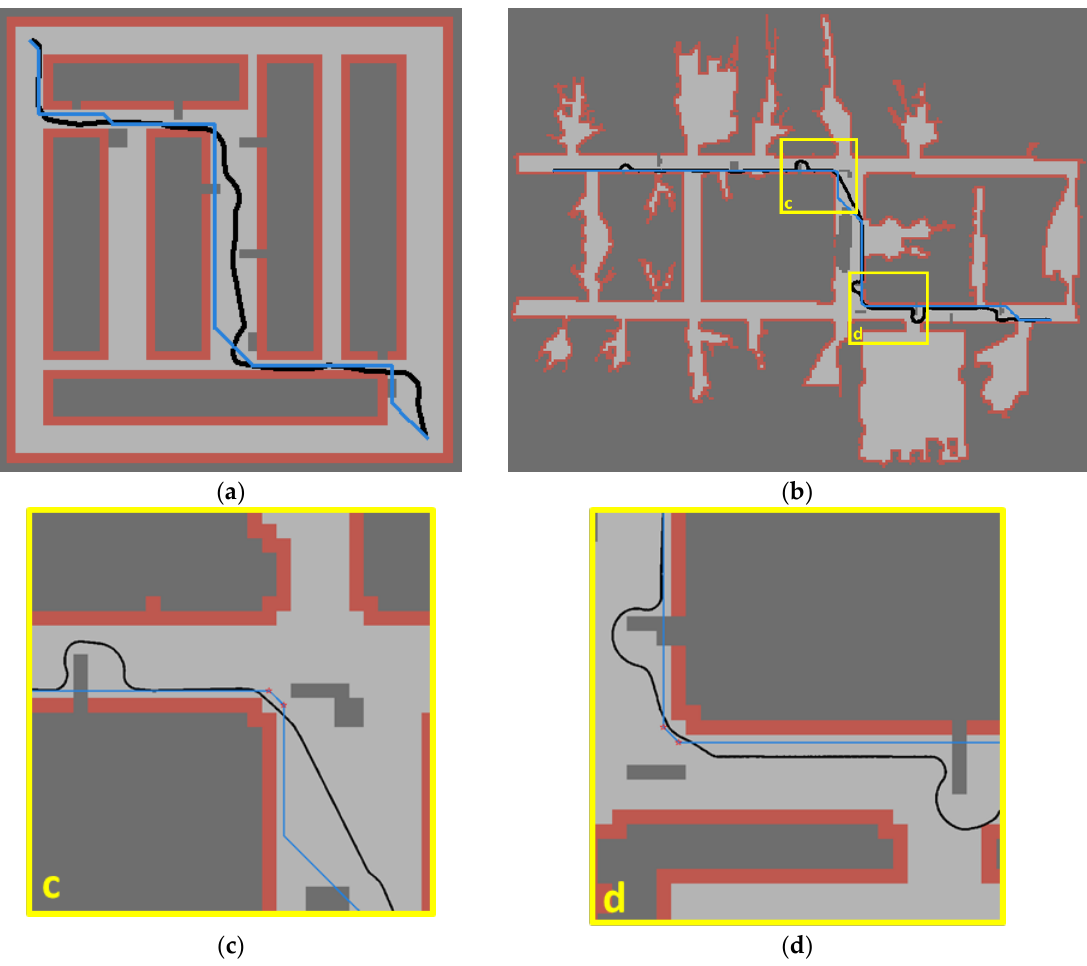
Figure 7. ( a , b ) The blue line is the path planned by SSG based on the map without unexpected obstacles. The black line is the trajectory planned by SG–RL without replanning the subgoal sequence. The dark-gray region is unpassable, while the light-gray region is traversable for robots. Red regions deemed close to obstacles denote alert areas. ( a ) Simplified office map with unexpected obstacles, ( b ) real office map with unexpected obstacles; ( c , d ) Two magnified details. ( c ) Magnified detail 1, ( d ) Magnified detail 2.